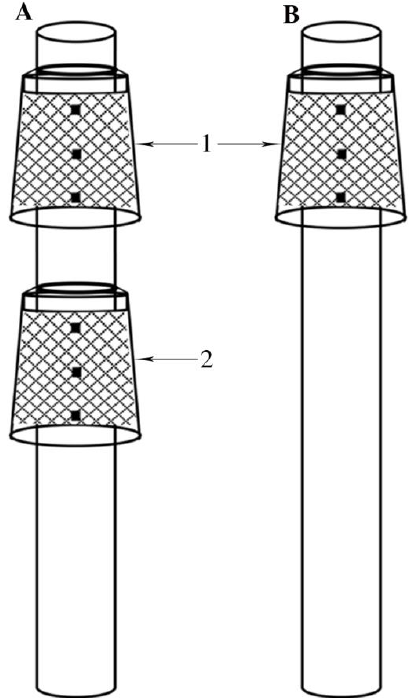
Figure 2. Diagram of the monitoring trunk trap net (MTTN). (1) MTTN. (2) TTN. ( A ) MTTN tied to